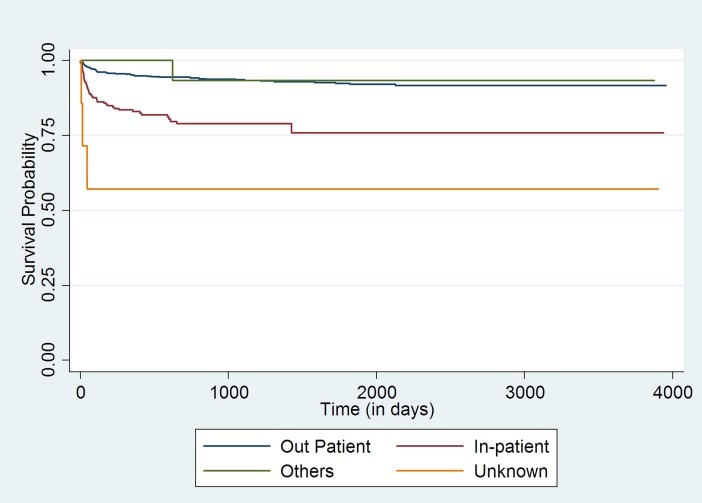
Unadjusted Kaplan-Meier survival curves for treatment outcome of HIV positive children who receiving ART in Mingalardon Specialist Hospital by entry point of care (2006 to 2016).Log rank test chi2 p-value: 0.0000.